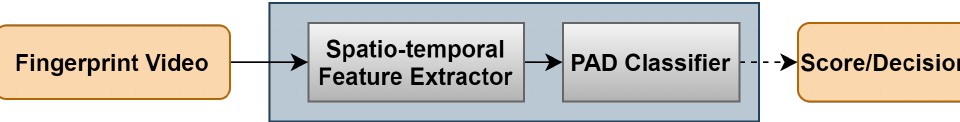
Figure 1. Dynamic PAD subsystem